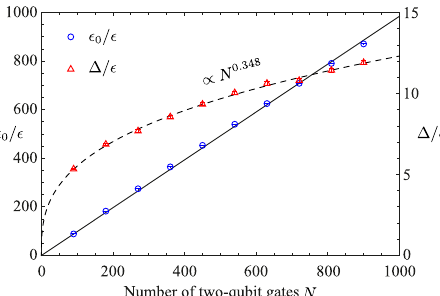
Fig. 8 Average depolarising rate ϵ 0 and standard deviation Δ in six-qubit periodic-cycling circuits. The axis on the left corresponds to ϵ 0 and the axis on the right corresponds to Δ . The error rate per two-qubit gate is ϵ = 2 × 10 − 4 , and the error rate of a single-qubit . The error bar represents one standard gate R is 0 : 1 π (cid:4) 1 ϵ arccos j Tr ð R Þj 2